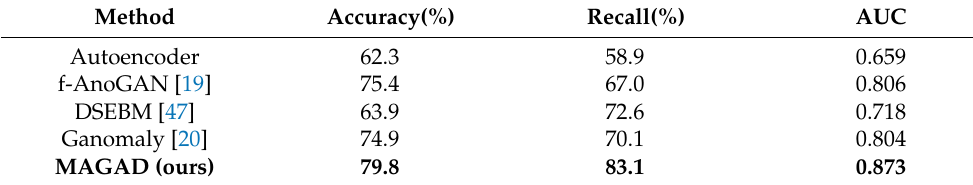
Table 3. Detection results of five models.